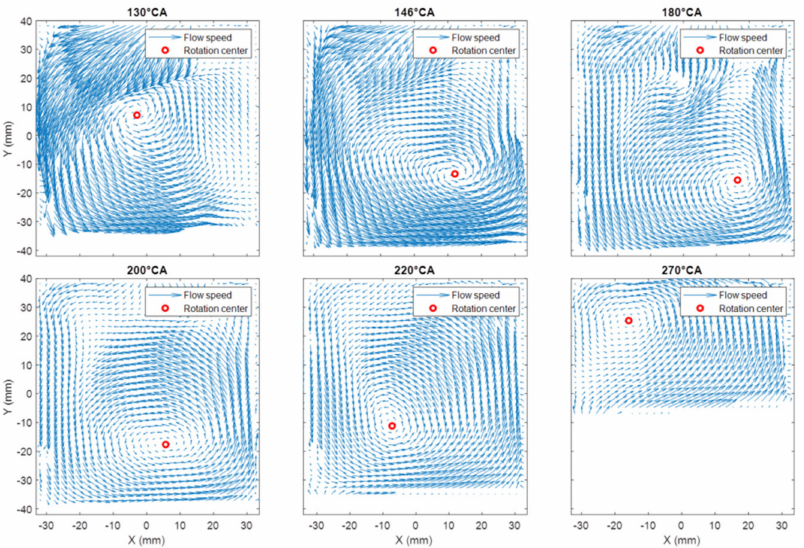
Figure 12. Mean field rotation center detection; θ VVT = 0 ◦ CA.